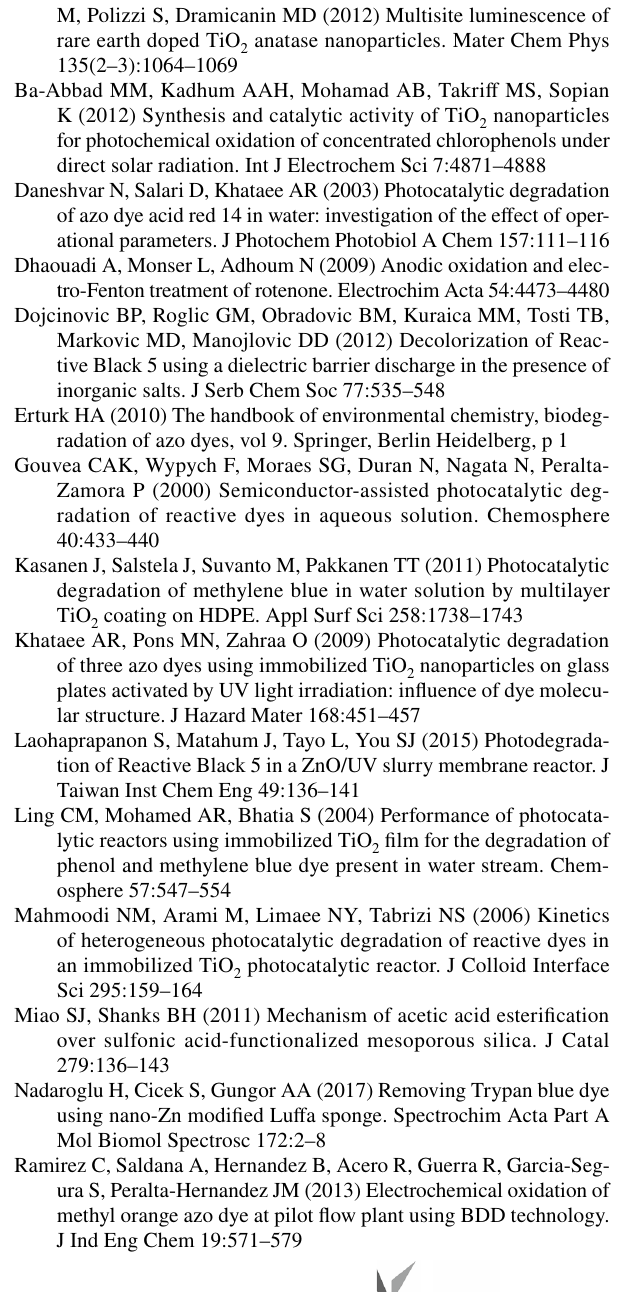
2 NPs-IML-CS on the